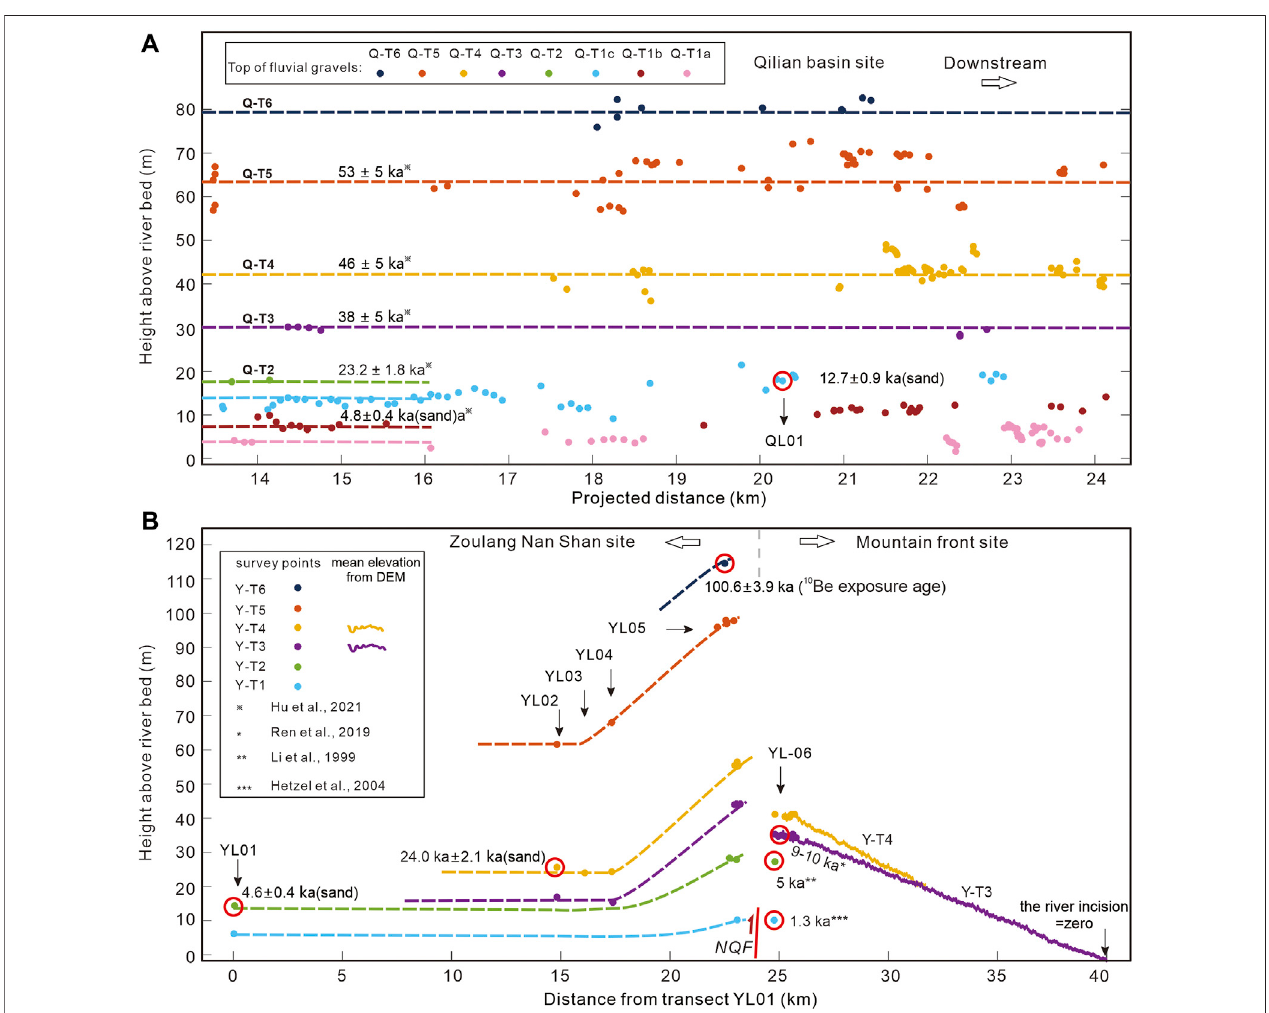
FIGURE 6 | Results of the terrace survey showing the longitudinal pro fi les (small colored dots) for each terrace level at the Qilian basin site (A) , the Zoulang Nan Shan site and the mountain front site (B) . The dashed lines are reconstructed pre-incision longitudinal pro fi les. The oscillations in the Y-T3 and T4 pro fi les are due to the lower resolution of the regional DEM.